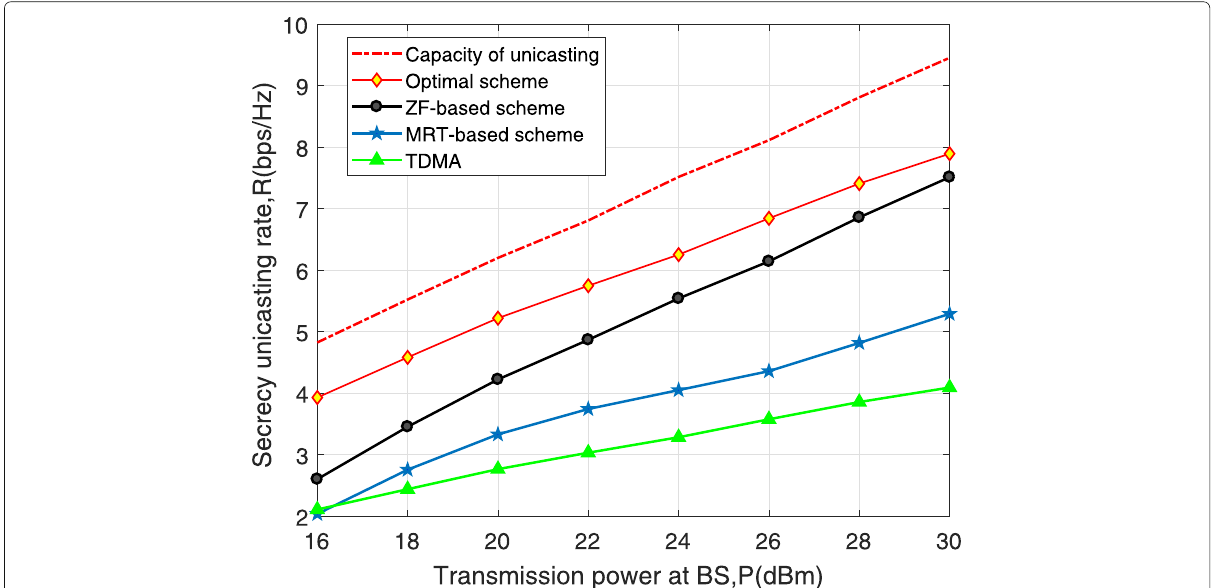
Fig. 4 Secrecy rate of unicasting versus the transmission power with R M = 1bps/Hz